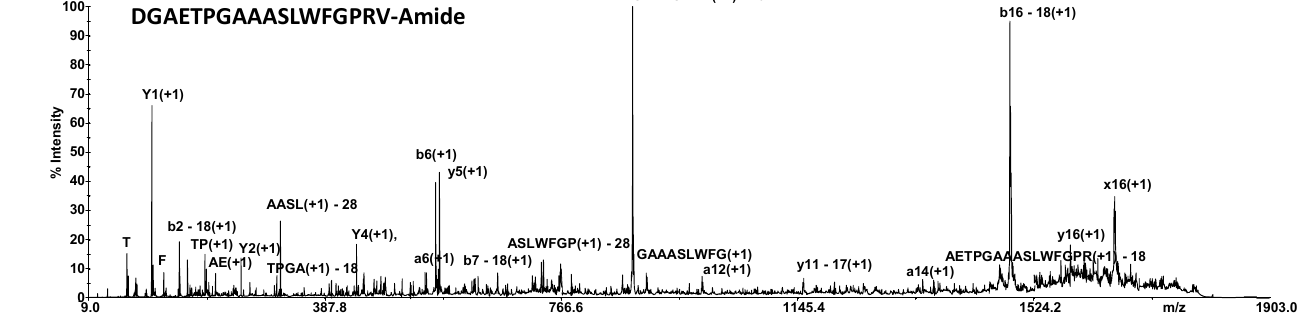
Figure 1. MALDI MS/MS of the m/z 1800.94. They regulate oogenesis and oviposition in the hemipteran Rhodnius prolixus [44] and heart physiology in Diptera [45]. In Tenebrio molitor and Zophobas atratus , they have myotropic effects in the regulation of contractile activity of the heart, ejaculatory duct, oviduct and the hindgut [46]. Allatotropins ( m/z 1367.77) and allatostatins such as allatostatin-3 (ALL3_RHOPR, m/z 1846.97), identified in the haemolymph of P. melas , have inhibitory or stimulatory effects, respectively, on juvenile hormone biosynthesis in the corpora allata [47]. The role of these peptides has also been demonstrated in regulating several other functions including release of digestive enzymes in the midgut [48], myostimulation influencing the physiology of hearts in the dorsal vassel, gut, and reproductive system. The allatostatin effects have been considered on the egg movements in the oviducts and food transit in tenebrionid beetles [49]. Some neuro-derivate factors in insects are involved in the maintenance of homeostasis. There are numerous families of diuretic and anti–diuretic peptides involved in controlling active transport processes of the gut including the creation of urine in the Malpighian tubules and the uptake of water and salts in the hindgut [50]. Antidiuretic factor “ADFa peptide” (ADFA_TENMO, m/z 1542.80) has not been detected outside coleoptera; it is probably the fragment of larger proteins that are not normally liberated and part of regulatory functions [51]. Antimicrobial peptides (AMP) are small proteins having a broad range of activity against bacteria, fungi and viruses as an essential factor for innate immune response [52]. Bombolitin ( m/z 1862.19), first isolated from Apoidea (Hymenoptera) venoms, is involved in the mast cell degranulation also showing as bactericide and fungicide properties [53]. Vespulakinin 1 ( m/z 1960.11) described in Vespula maculifroms is a vasoactive peptide [54]. Phospholipases A2 (PLA2, m/z 2637.59) have been described in various hymenopteran species and act as neuro- and myotoxins by hydrolyzing membrane phospholipids of motor nerves and subsequently leading to cell lysis [55]. Metalnikowin IIB ( m/z 2040.10) is a proline-rich antimicrobial peptide [56], first identified in Palomena prasina [57]. Cecropins ( m/z 4083.40) first isolated from the haemolymph of pupae in giant silk moths, Hyalophora cecropia , were recognized as a part of immune response in Lepidoptera, Coleoptera, and Diptera [58]. Cecropins are released by fat bodies and haemocytes in haemolymph and have broad range of antimicrobial